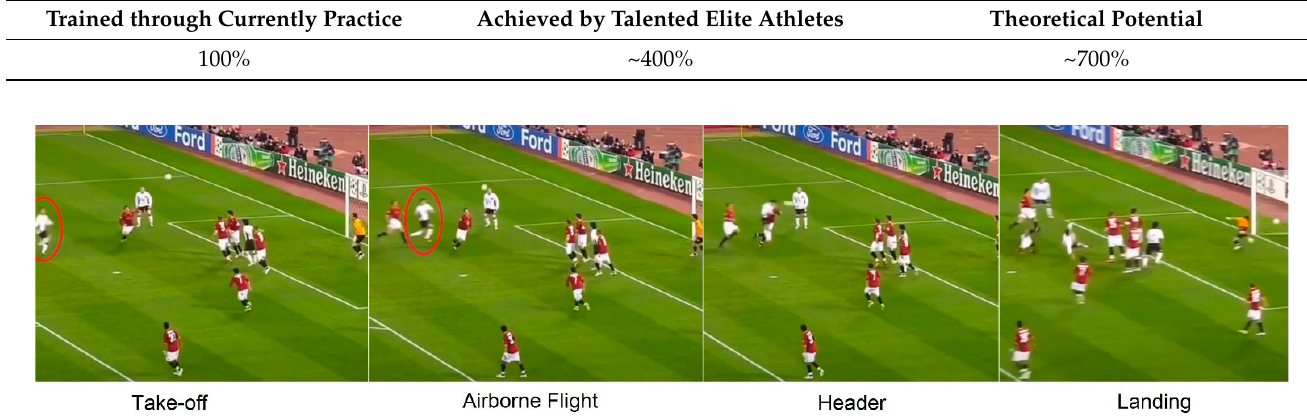
Table 1. The comparison of the proprioceptive/effective shooting volume from the current practice (100%) to the player-centered temporal-spatial training of airborne/acrobatic SSTs.